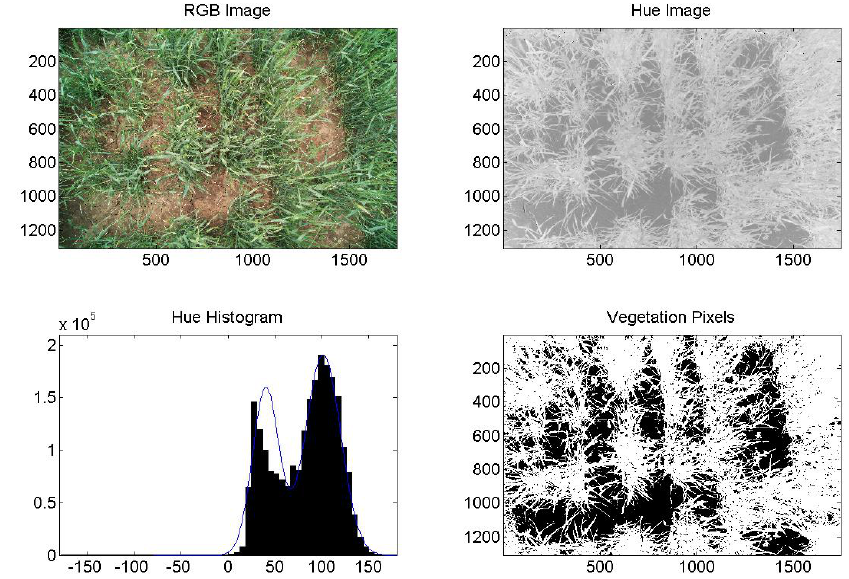
Figure 5. Example image analysis for wheat, DOY 137, 2011, healthy, 100%. Axes on images are in pixels. Pixels classified as vegetation are shown in white (lower right).